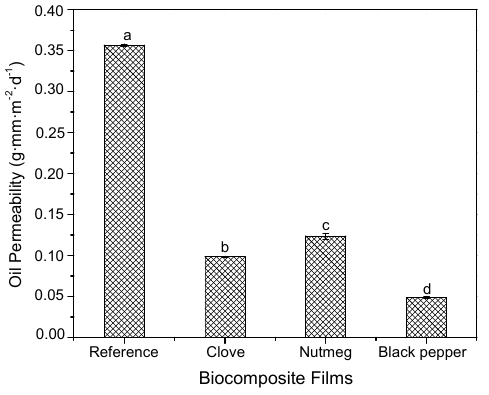
Figure 6. Oil permeability of biocomposite films with oleoresins and reference. Different letters in the same column indicate significant differences ( p < 0.05).